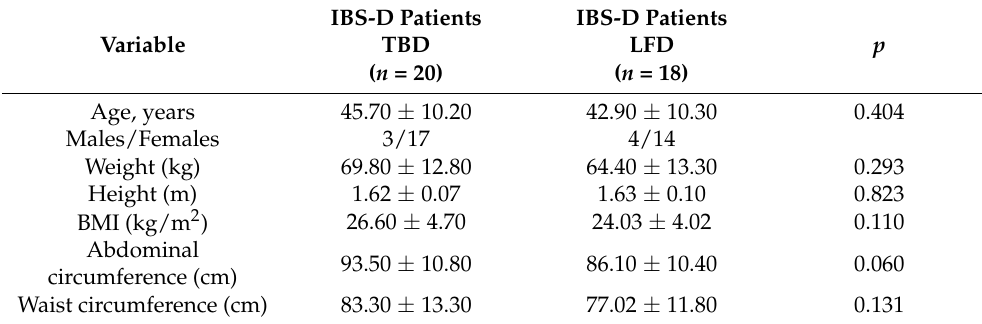
Table 1. Baseline anthropometric characteristics of IBS-D patients categorized according to